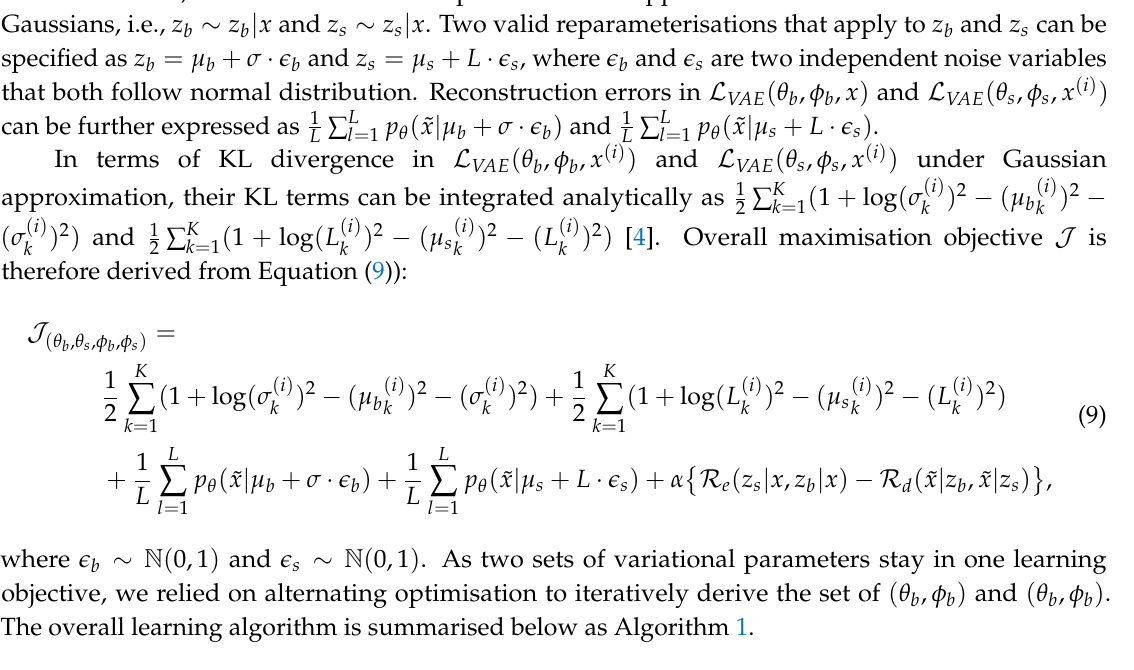
Algorithm 1 EVAE learning